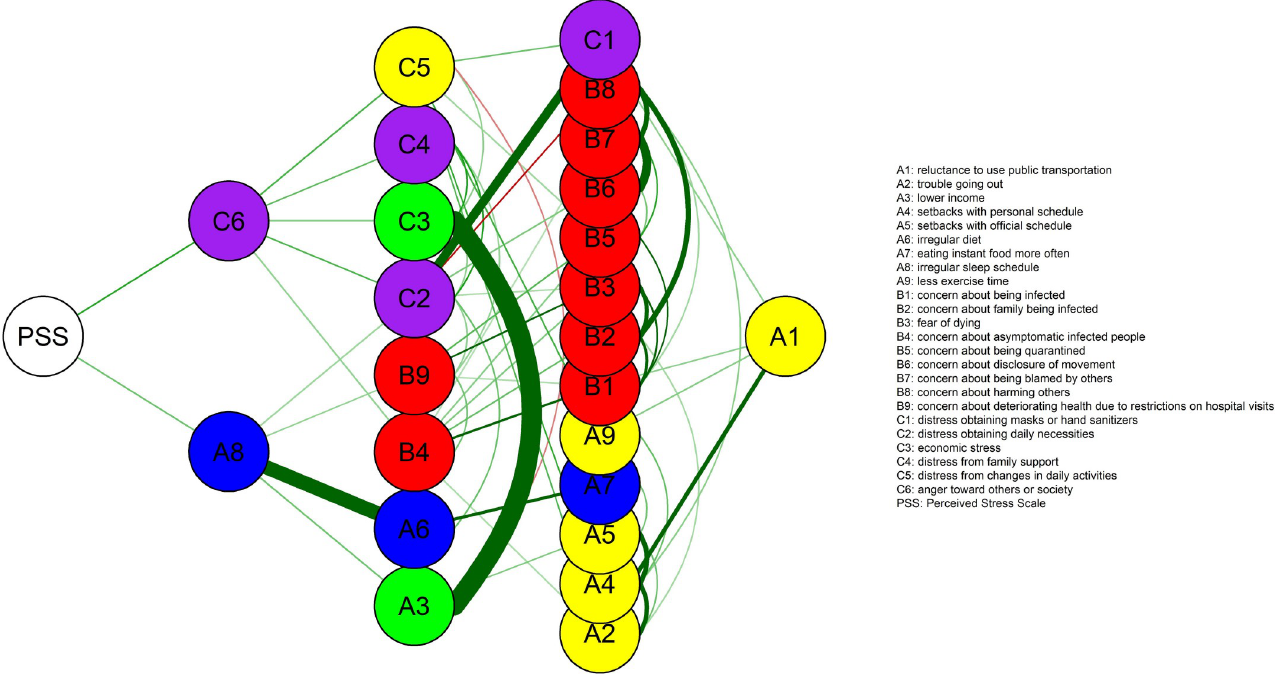
Fig 3. Flow diagram from the Perceived Stress Scale (PSS) node. A PSS node represents the total score of the 10-item PSS.